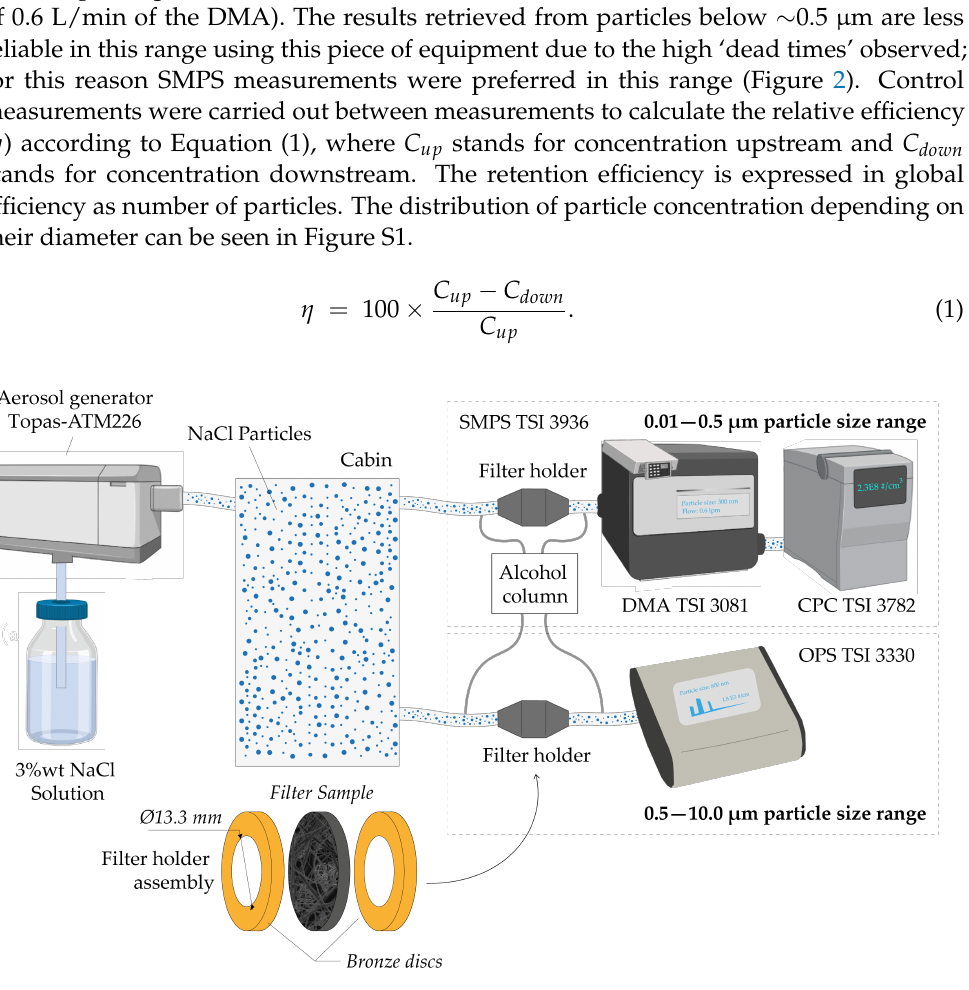
Figure 2. Schematic representation of the equipment used for the particle penetration